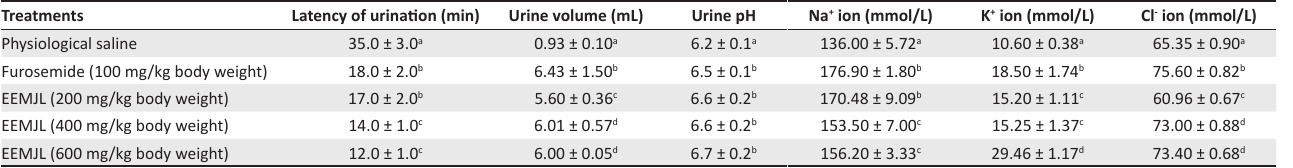
TABLE 2: Selected urinary parameters of male rats after oral administration of ethanol extract of Mirabilis jalapa leaf. Treatments